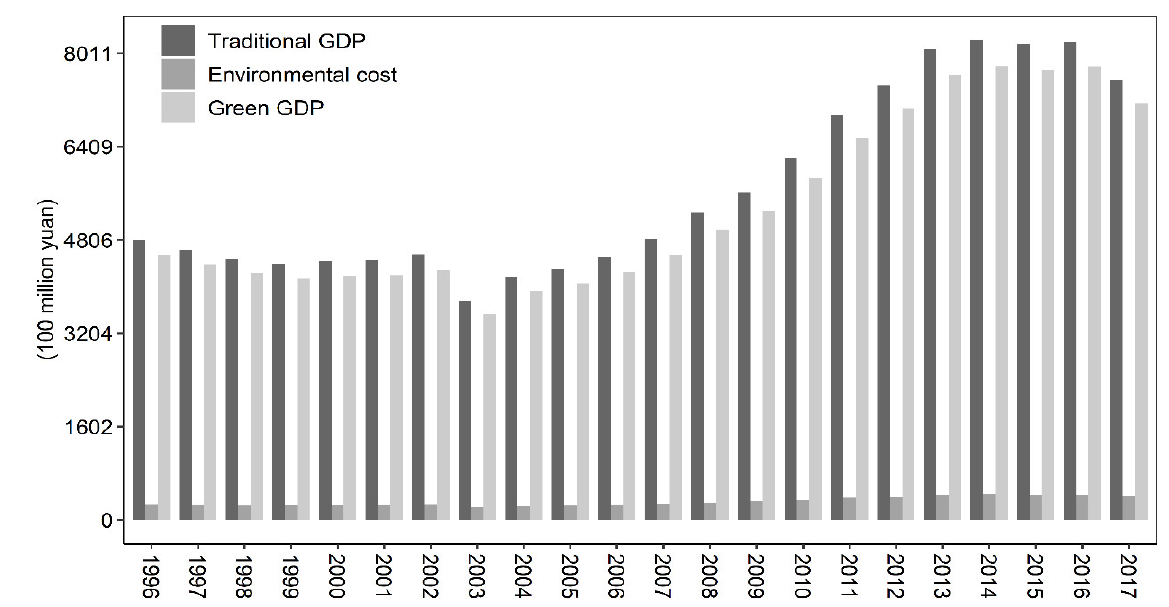
Figure 5. Traditional GDP, environmental cost, and green GDP, 1996–2017. From the rate of green GDP to traditional GDP (Figure 6), China’s agricultural growth can be roughly divided into two stages. During the period from 1996 to 2003, the rate of green agricultural GDP/traditional agricultural GDP dropped rapidly, from 0.9443 to 0.9393, indicating that the cost of environmental erosion of agricultural resources in China has increased year by year. After 2003, the rate showed a fluctuating upward trend, rising from 0.9393 to 0.9458, indicating that the cost of environmental loss of agricultural resources in China has been decreasing year by year.